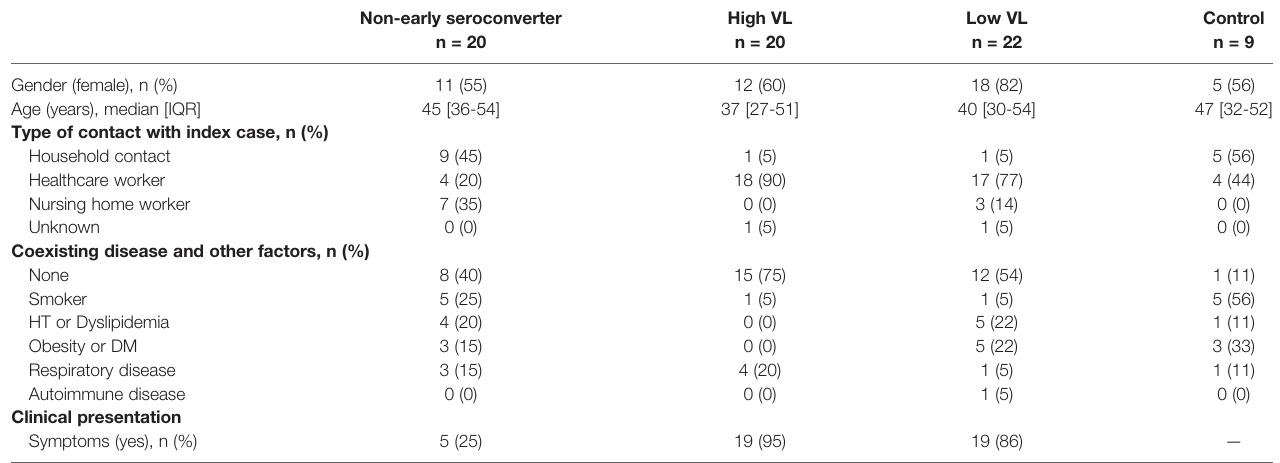
TABLE 1 | Description of